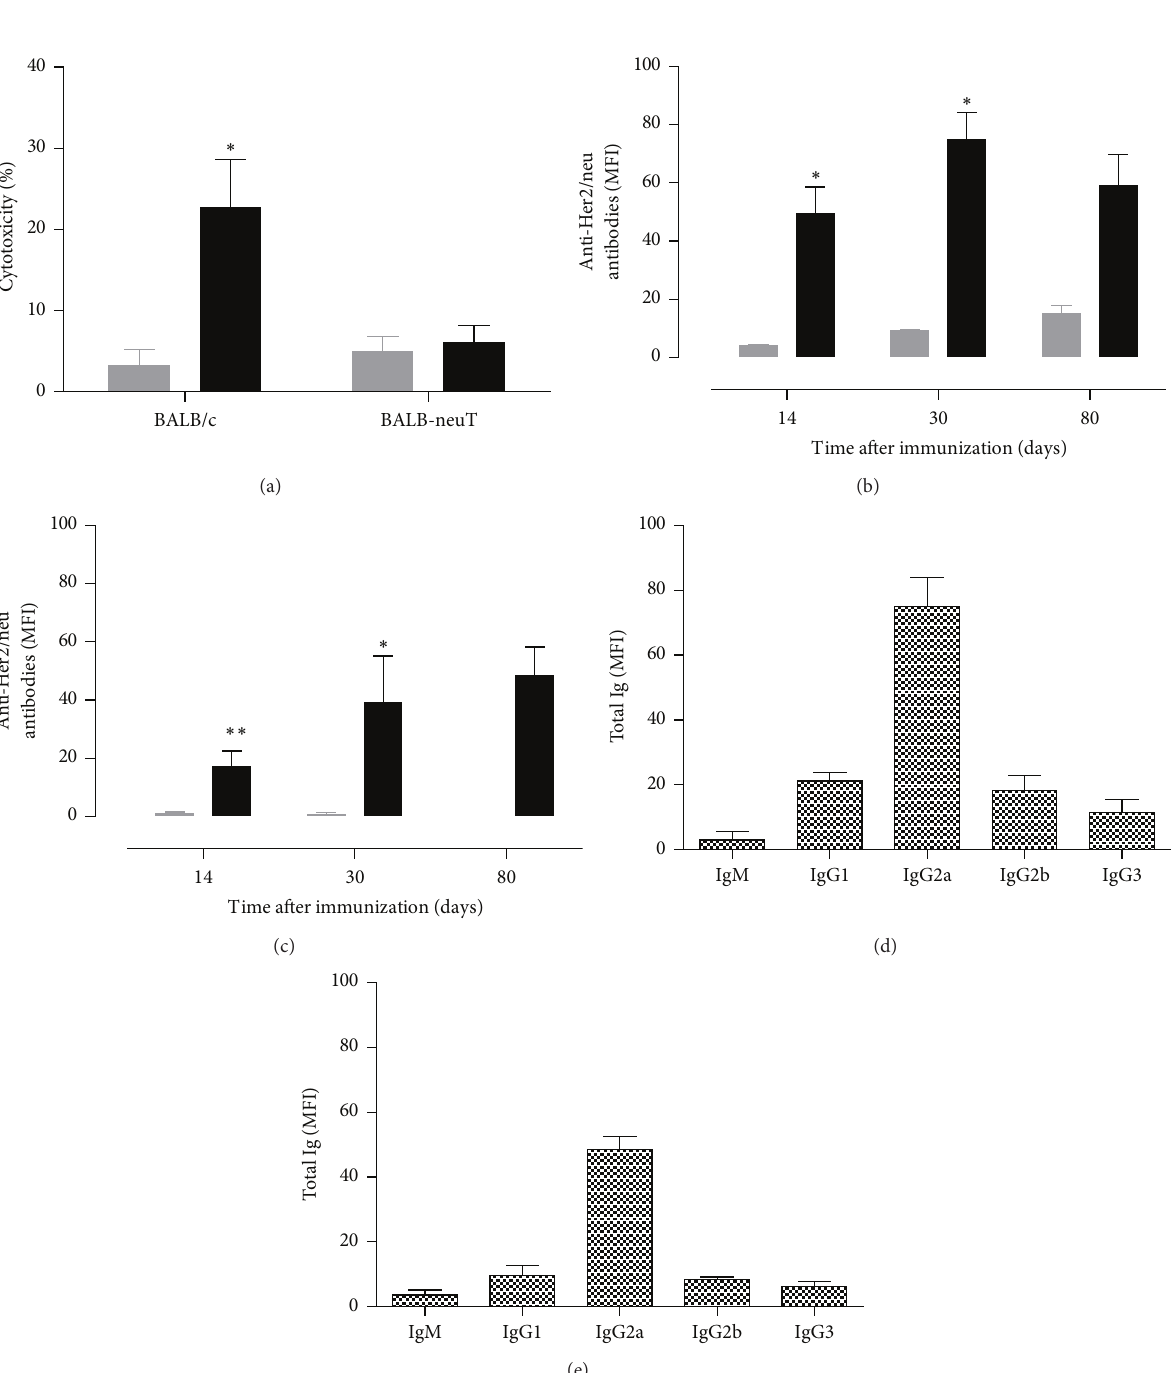
Figure5:IntradermalEPvaccinationinducescellularresponseinHer2/neunontolerantmiceandhumoralimmuneresponseinbothtolerant and nontolerant mice. In vivo cytotoxicity against the H-2 d dominant peptide in BALB/c and BALB-neuT (each experimental group 𝑛 = 3 ) mice vaccinated with pVAX (gray bars) or pVAX-ECTM plasmid (black bars). Data are reported as % of lysis. ∗ 𝑝 = 0 , 0369 , Student’s 𝑡 -test. (a) Anti-Her2/neu antibody titer (MFI ± SEM) in BALB/c (b) and BALB-neuT mice (c). ∗∗ 𝑝 = 0 , 0096 , ∗ 𝑝 < 0 , 0242 , Student’s 𝑡 -test ((b), (c)). Isotype titration, performed in three different pools of sera, revealed similar composition of Her2/neu specific antibodies for BALB/c (d) and BALB-neuT (e) treated mice ((d),